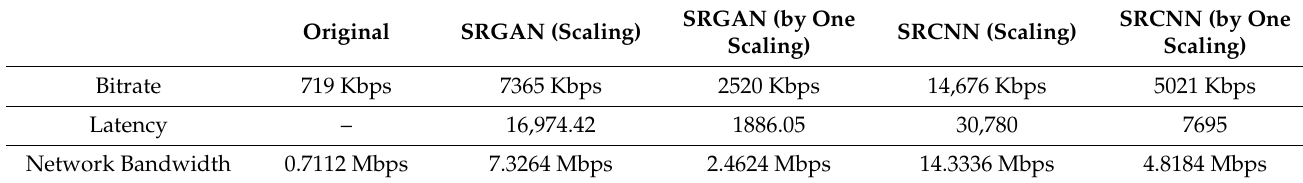
Table 2. Compare each network of the 360 ◦ video.